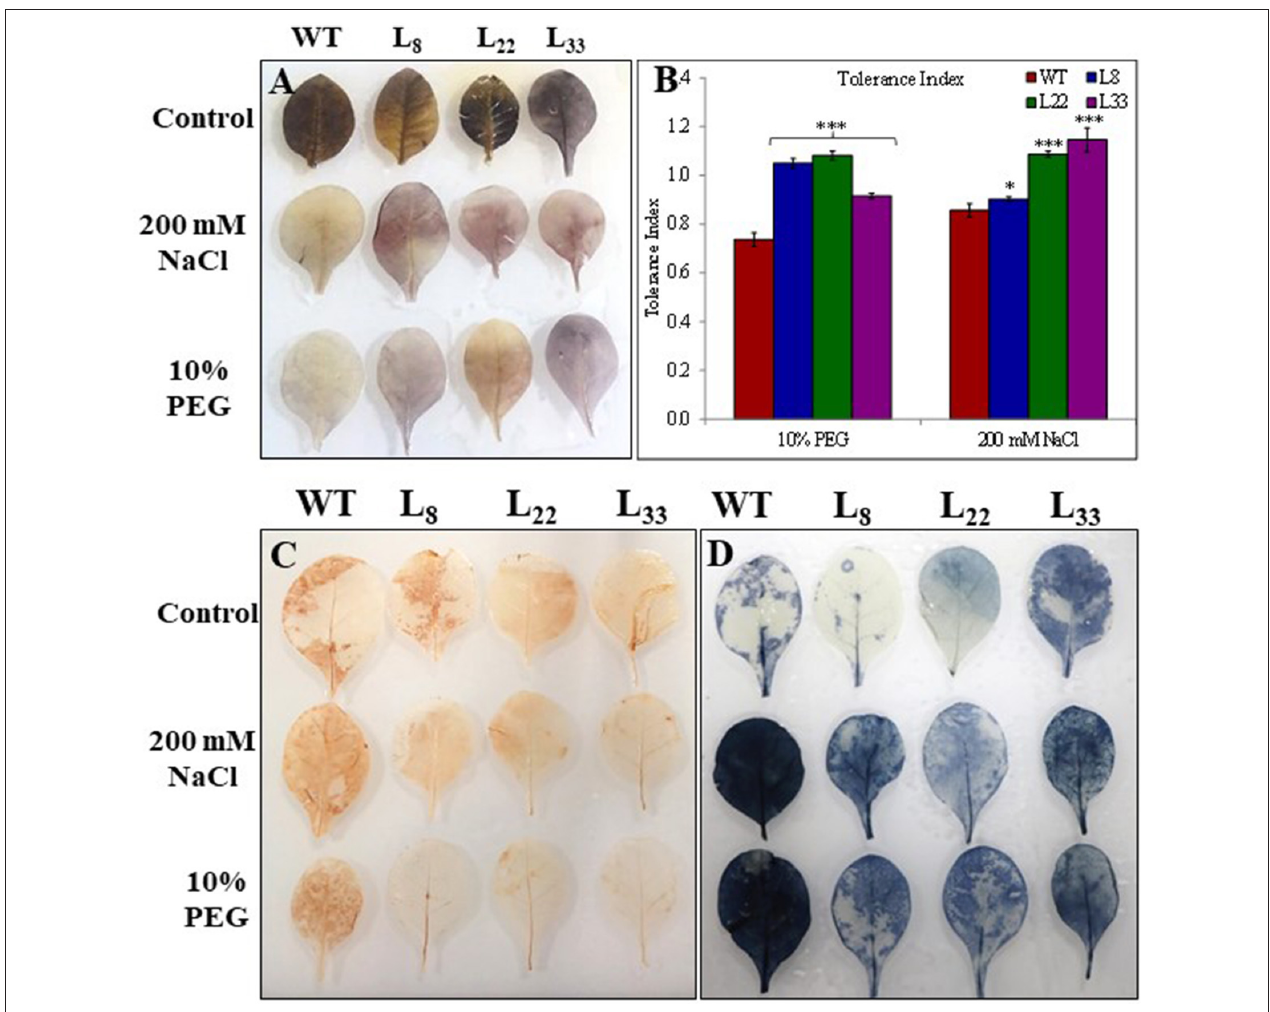
FIGURE 5 | Accumulation of starch in leaves (A) , tolerance index (B) , and in vivo detection of O − 2 (C) and H 2 O 2 (D) in leaves of WT and transgenic tobacco under control and stress (drought and salt) conditions. The * and *** denote statistical significance in responses of transgenic lines against control at P value ≤ 0.05 and 0.001